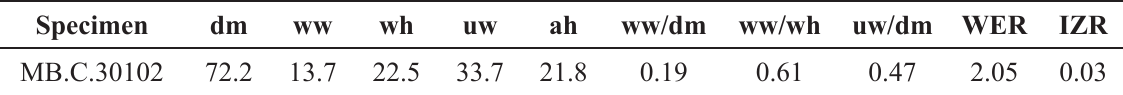
Table 37. Conch dimensions (partly estimated) and ratios of the holotype of Stoyanowites parallelus Korn & Hairapetian sp. nov. from Baghuk Mountain.